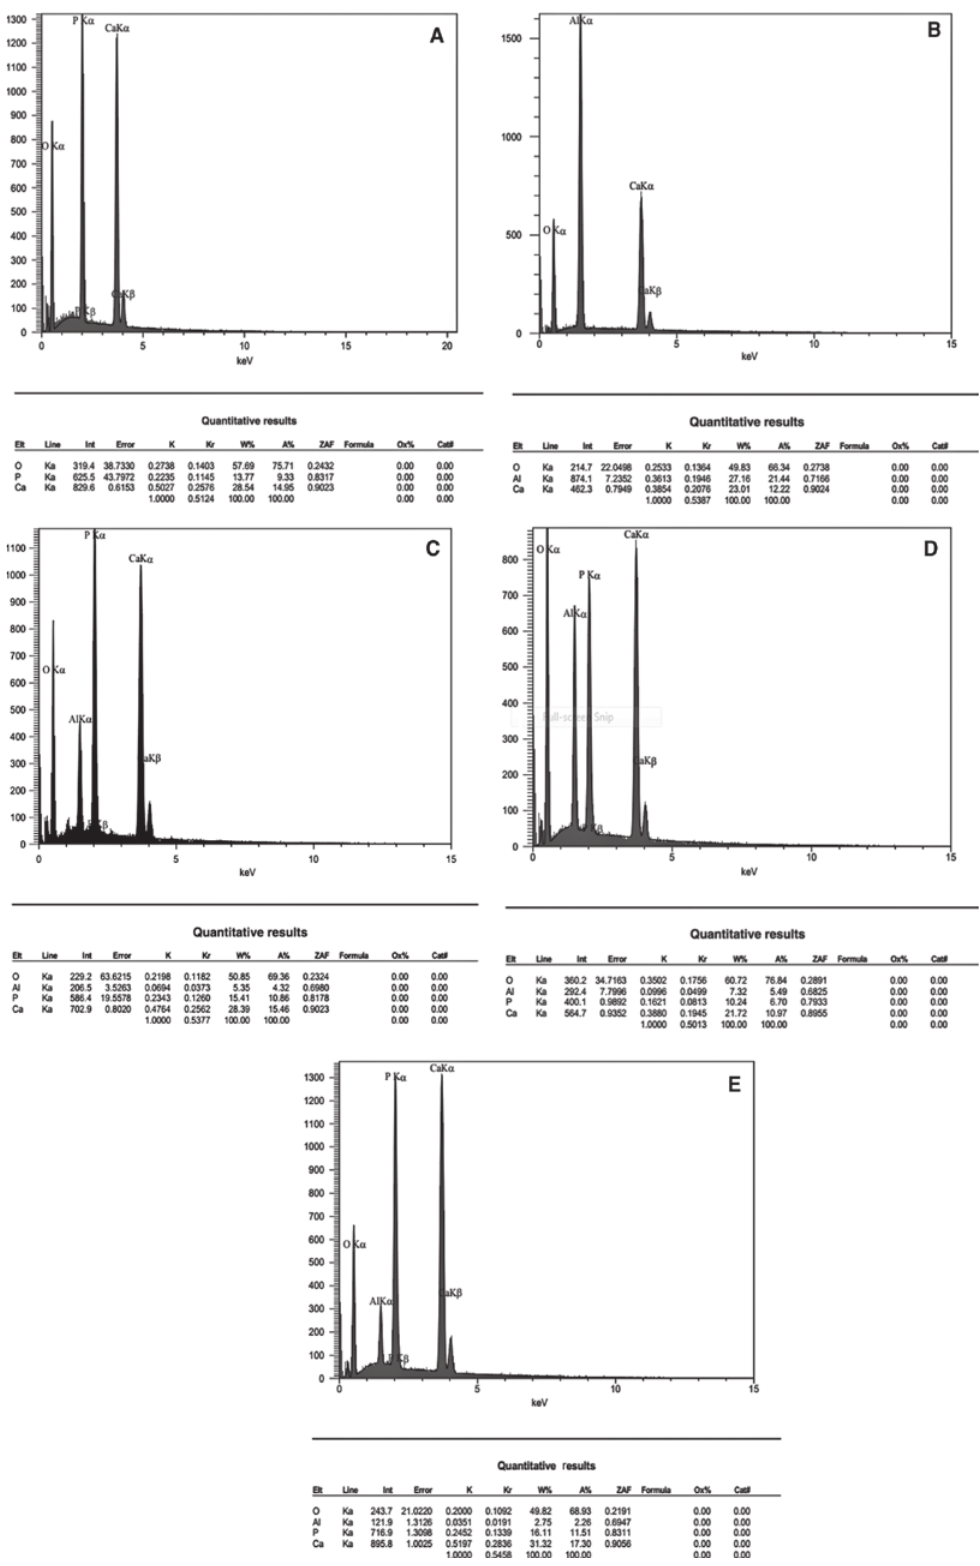
Figure 3: EDX spectra for samples before immersion in